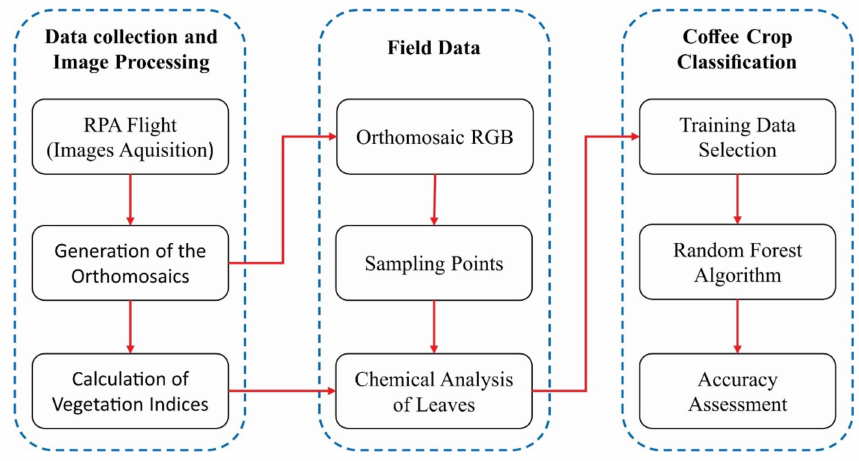
Figure 1. Workflow used in the methodology of this study.